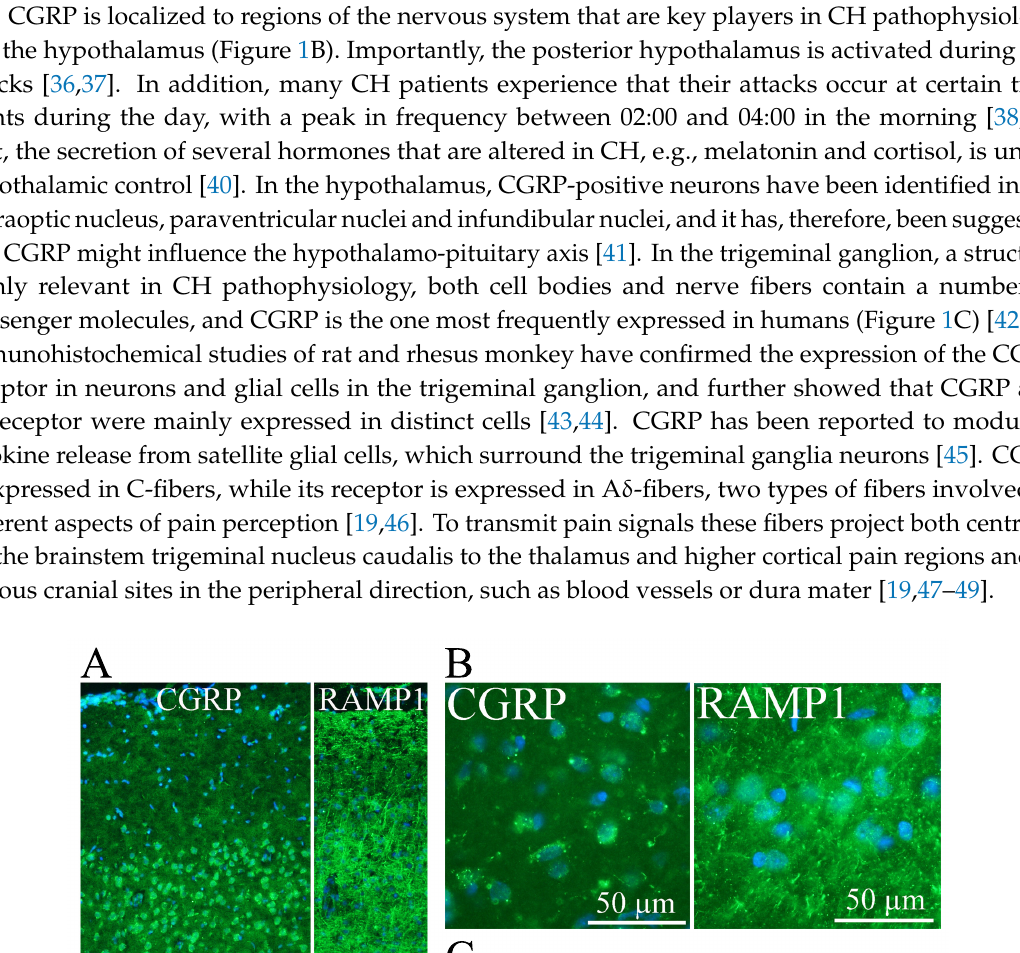
Figure 1. GlcNAc metabolic pathways in Candida albicans . Catabolic proteins are indicated in red and anabolic proteins are indicated in green. Arrows indicate the direction of the biochemical activity. GlcNAc is transported into the cell by Ngt1 and then phosphorylated by Hxk1. It can then be converted into fructose-6-PO 4 and metabolized. Alternatively, GlcNAc-6-PO 4 can enter the anabolic pathway and be converted into UDP-GlcNAc, a key building block of cell wall chitin, GPI-anchors on proteins, and N -glycosylation of proteins. Note that cells only synthesize GlcNAc-6-PO 4 so the presence of non-phosphorylated GlcNAc can act as a unique signal for the presence of exogenous GlcNAc.